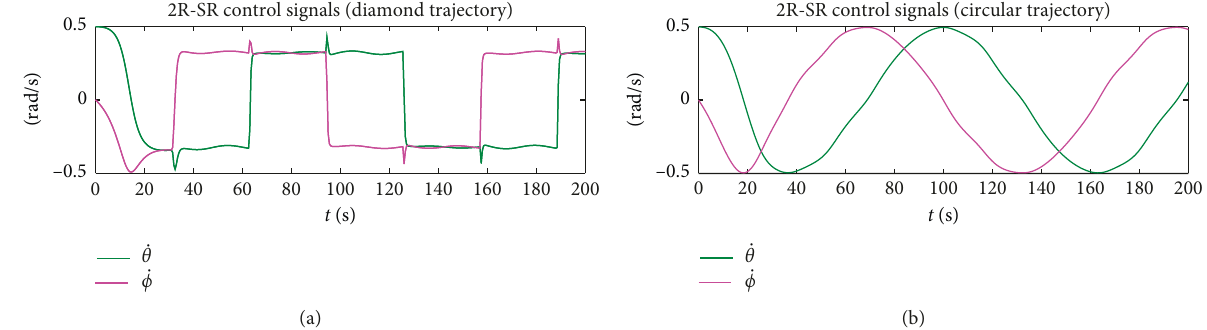
Figure 10: 2R-SR control signals for smooth and nonsmooth trajectories.